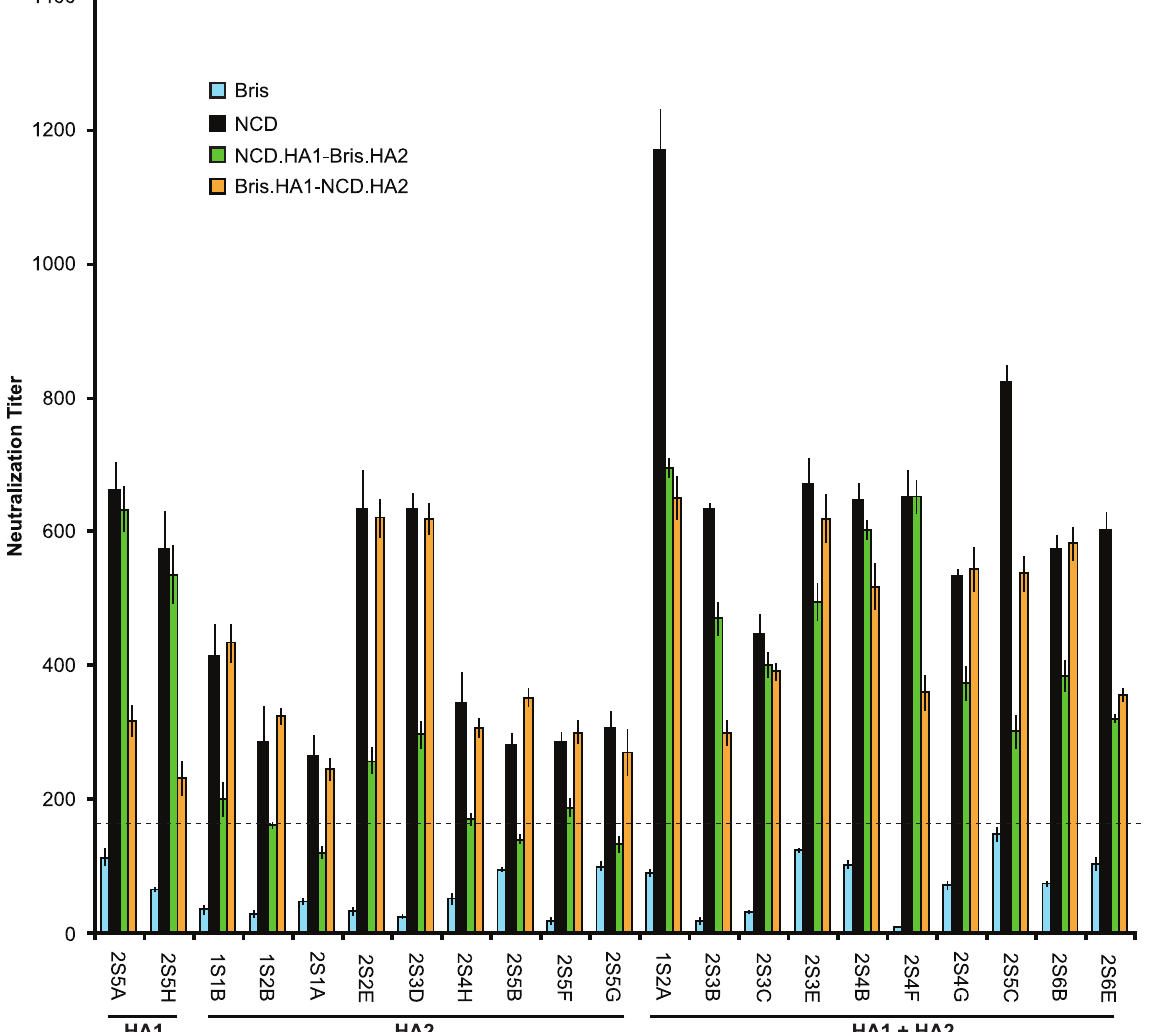
Figure 4. Cross-neutralization to NCD/20/99 from NJ/76 vaccination frequently maps to HA2. Bris.HA1-NCD.HA2 and NCD.HA1-Bris.HA2 pseudotypes were used to map the target of cross-neutralizing antibodies in the sera from the NJ/76 vaccine trials with neutralization titers to NCD/ 20/99, but not to Bris/59/07. The dotted line represents a neutralization titer of 160, which has been proposed as a correlate of seroprotection in microneutralization assays involving replicating influenza virus [4]. Protective titers for neutralization of HA-pseudotypes have not been determined. Data are shown as means + / 2 SD and reflect two or more independent experiments with each sample run in duplicate. Bris: Bris/59/07; NCD: NCD/